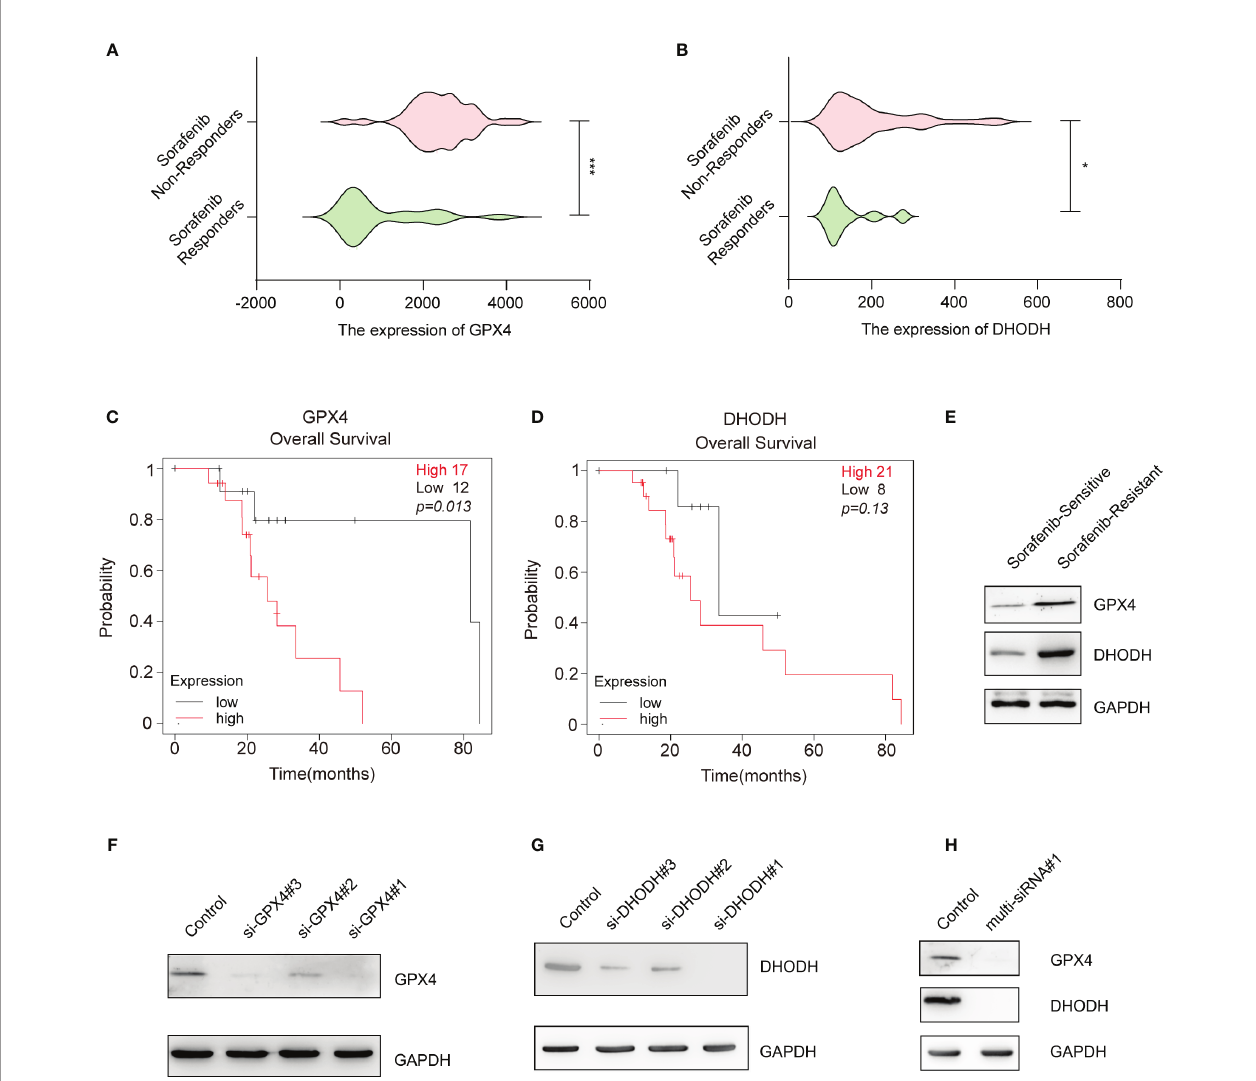
FIGURE 2 | Gene-silencing activities of multi-siRNA against GPX4 and DHODH genes. (A) GPX4 expression in HCC tissues from sorafenib responders (n=21) or sorafenib nonresponders (n=43) (gse109211). (B) That of DHODH in the HCC tissues of sorafenib responders (n=21) or sorafenib nonresponders (n=43) (gse109211). (C) Kaplan – Meier overall survival analysis of the GPX4 gene in HCC patients who received sorafenib treatment. (D) Kaplan – Meier overall survival analysis of the DHODH gene in HCC patients who received sorafenib treatment. (E) Western blotting for assessment of the protein levels of DHODH and GPX4 in sorafenib-sensitive HepG-2 or sorafenib-resistant HepG-2 (HepG-2R) cells. (F) Western blotting was conducted to detect GPX4 expression in HepG-2R cells transfected with scramble or GPX4 siRNAs. (G) Western blotting was conducted to detect DHODH expression in HepG-2R cells transfected with scramble or DHODH siRNAs. (H) HepG-2R cells were transfected with scramble siRNA or multi-siRNA#1 containing the si-GPX4#1 and si-DHODH#1 target sequences, and Western blotting was conducted to detect GPX4 and DHODH expression. (A, B) Unpaired t -test. (C, D) Log-rank test. * p < 0.05, *** p <